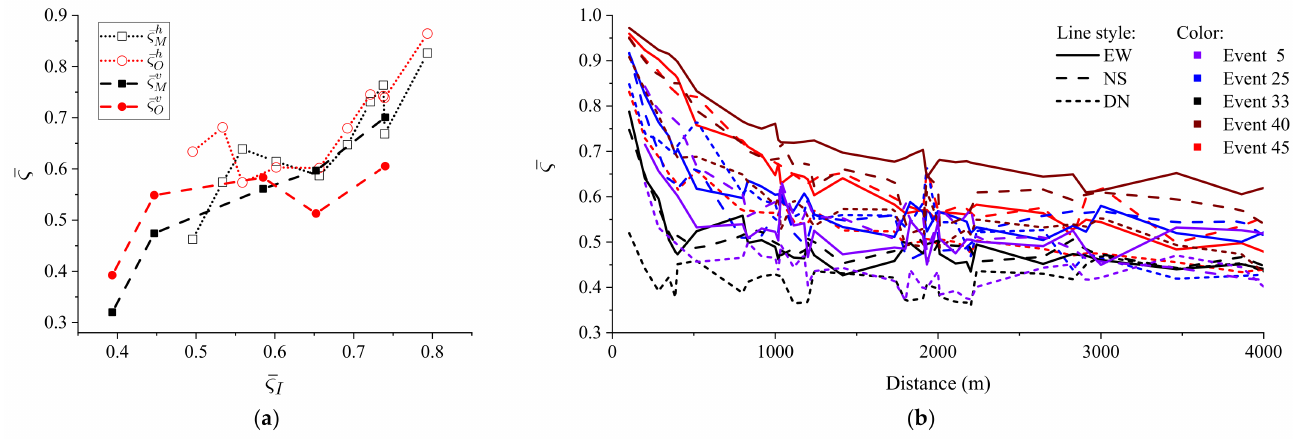
Figure 5. Relationships between ς I , ς M , and ς O : ( a ) Ring-wise, ( b ) Pair-wise.